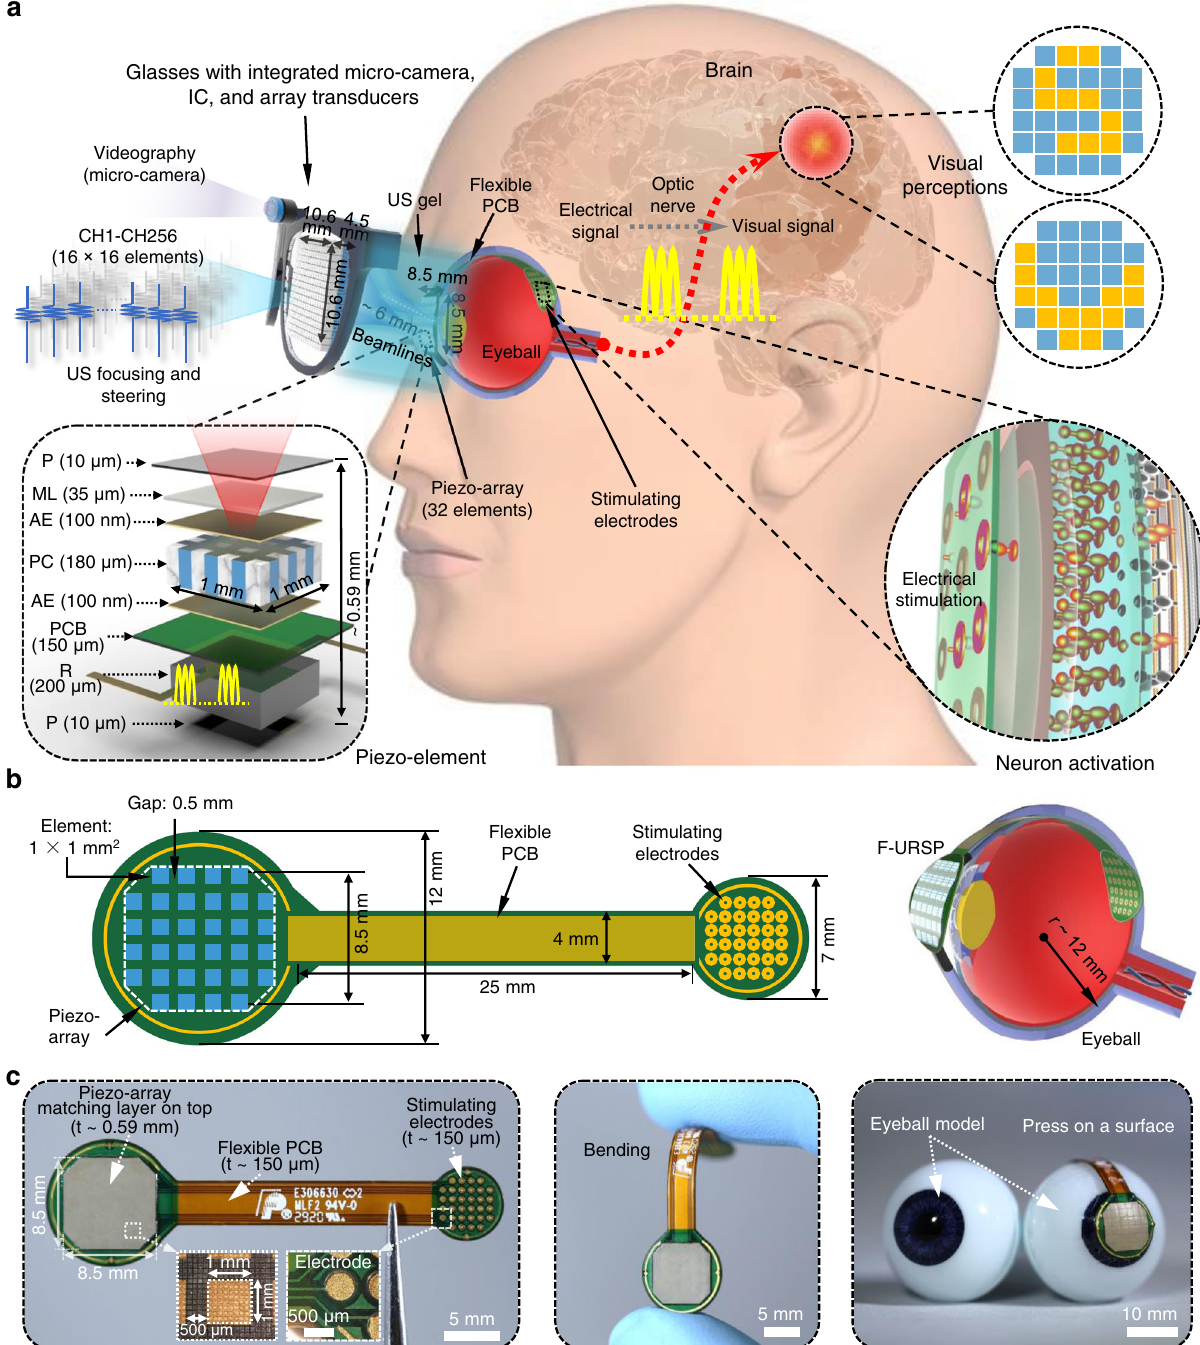
Fig. 1 Design structure and working principle of the F-URSP. a Schematic diagram showing the fl exible ultrasonic device, with key components and aspect ratios labeled. The implantable F-URSP consists of a high-performance piezo-composite array, recti fi ers, and an electrode array integrated into a fl exible PCB. Each piezo-channel (CH1-CH32) in the array works individually and can convert the transmitted US wave into electricity which is recti fi ed and then used for electrical stimulation of retinal neurons through the integrated electrodes. The correspondingly induced action potentials would be conducted to the central visual pathway via the optic nerve to produce visual perception. Therefore, the F-URSP architecture leverages the advantage of the programmable US beam to realize the visual projection of complex patterns wirelessly. A micro-camera for videography and an integrated chip (IC) for optical picture-to-program processing will be designed and integrated into the glasses in the future to excite the array. P, Parylene-C/coating (10 μ m), protection for PZT; ML, matching layer (35 μ m), enhancement of acoustic transmittance; PC, piezo-composite (180 μ m), acoustic-electric conversion element; PCB, printed circuit board (150 μ m), fl exible circuit carrier; R, recti fi er (200 μ m), AC-DC conversion; AE, Au/Cr electrode (100nm), electrodes of the piezo-element. b Schematic diagram showing structure and dimensions of the F-URSP. The design refers to the size of the human eyeball (radius~12mm) for future implant applications. c Photographs showing the as-fabricated fi nal F-URSP with soft con fi guration ( t ,